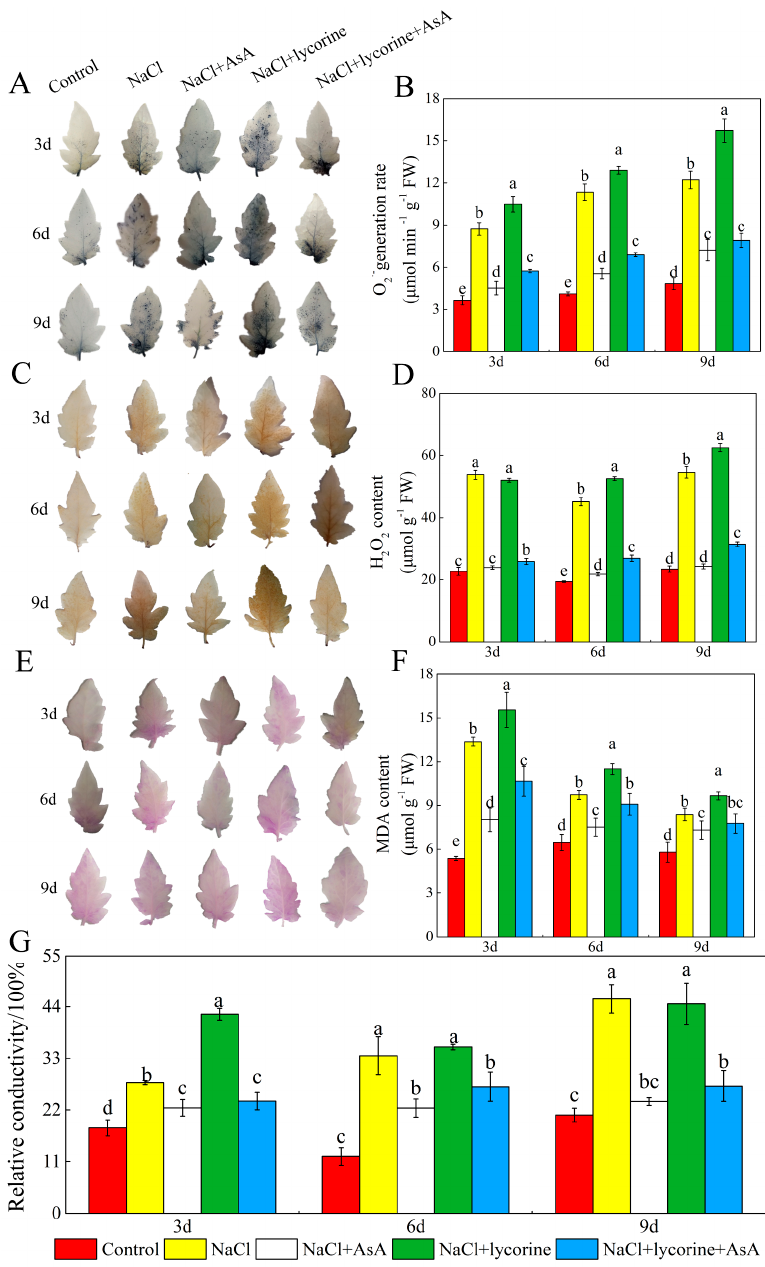
Figure 7. Values of histochemical detection of superoxide anion (O 2 − ) ( A ), O ·− content ( B ), histochemical detection of hydrogen peroxide (H 2 O 2 ) ( C ), H 2 O 2 content ( D ), histochemical detection of MDA ( E ), MDA content ( F ), and relative conductivity ( G ) in leaves of salt-stressed tomato seedlings with or without exogenous reduced ascorbic acid (AsA) and lycorine (AsA synthesis inhibitor) spraying. Abbreviations 3d, 6d, and 9d represent the third, sixth, and ninth day after treatment, respectively. Control, no added NaCl and sprayed with distilled water; NaCl, added 100 mmol · L –1 NaCl and sprayed with distilled water; NaCl + AsA, added 100 mmol · L –1 NaCl and sprayed with 0.5 mmol · L –1 AsA; NaCl + lycorine, added 100 mmol · L –1 NaCl and sprayed with 0.25 mmol · L –1 lycorine; NaCl + lycorine + AsA, added 100 mmol · L –1 NaCl and sprayed with 0.25 mmol · L –1 lycorine plus 0.5 mmol · L –1 AsA. Values are means ± SD ( n = 3). Values with a different letter within a sampling date are significantly different ( p <